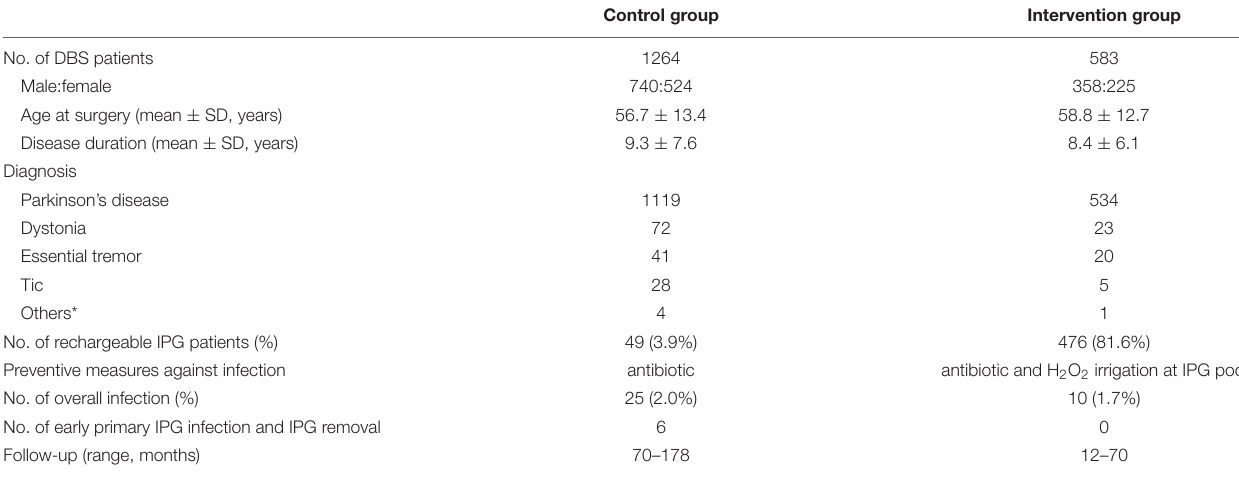
TABLE 1 | Demographics of control group and intervention group.